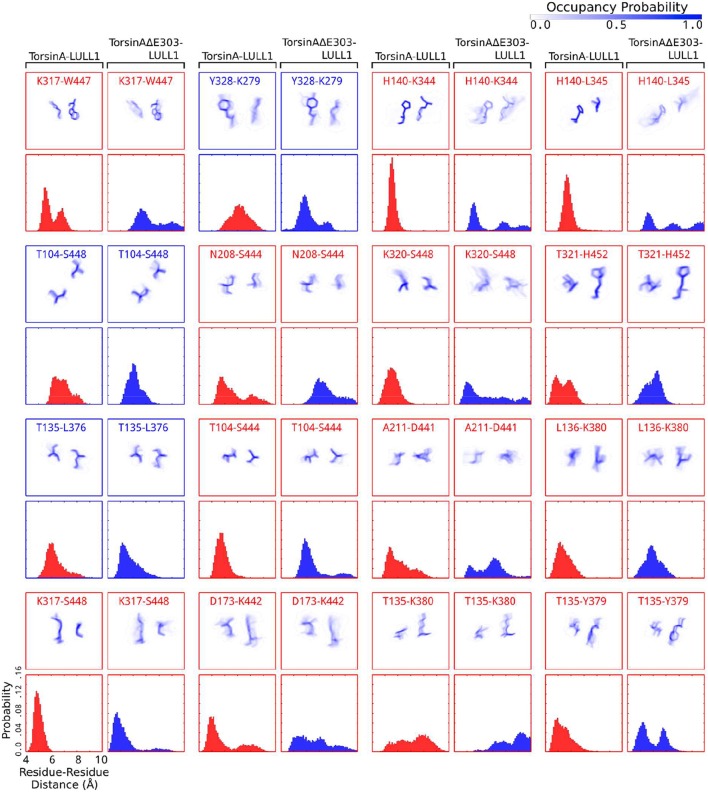
Detailed account of the effects of ΔE303 on the distributions of contacts/distances between TorsinA's residues and LULL1's residues. We show a more detailed account of the effects of ΔE303 on residue-residue (“amino acid of TorsinA/TorsinAΔE303”–“amino acid of LULL1” e.g., K317-W447) distances. A red bounding-box shows that (for the given TorsinA-/TorsinAΔE303-LULL1 residue pair) TorsinA-LULL1 interactions are better than TorsinAΔE303-LULL1 based on a cut-off distance of 6 Å, otherwise a blue bounding-box. In each group of four boxes, the top row shows the distributions of the positions of the amino acid of TorsinA-/TorsinAΔE303 and that of LULL1 in form of occupancy probability ranging from 0.0 (white) to 1.0 (dark blue), while the bottom row contains histograms showing the distributions of TorsinA-/TorsinAΔE303-LULL1 distances. The residue pairs average distances were sorted in descending order based on the magnitude of the differences between TorsinA-LULL1 and TorsinAΔE303-LULL1 such that those with the largest absolute differences are listed first. Only 16 pairs are shown in this figure. Additional examples are presented in Supplementary Figure S1.